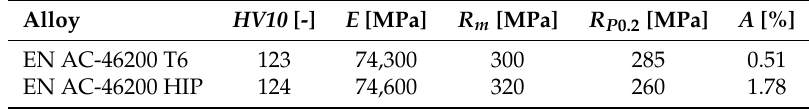
Table 3. Tested material properties of EN AC-46200 with T6 and HIP heat treatment. Alloy HV10 [-] E [MPa] R m [MPa] R P 0.2 [MPa] A [%] EN AC-46200 T6 123 74,300 300 285 0.51 EN AC-46200 HIP 124 74,600 320 260